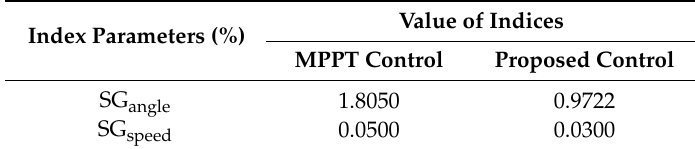
Table 2. Values of indices for performance comparison during a 3LG